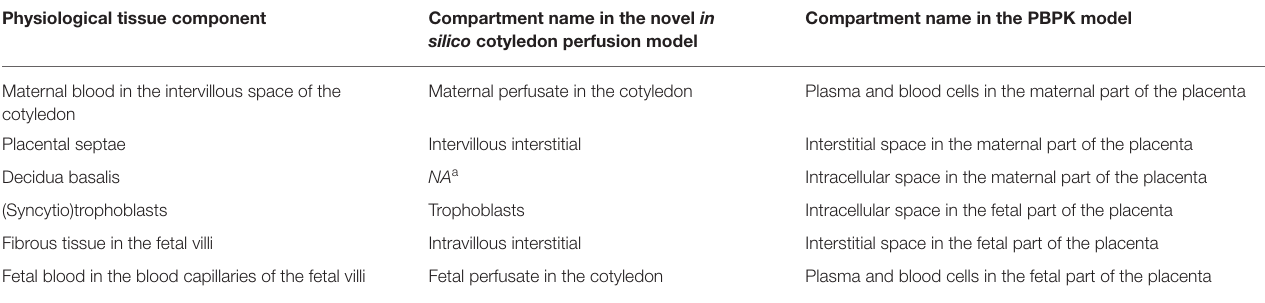
TABLE 1 | Overview of different tissue components and their corresponding compartments in the novel in silico cotyledon perfusion model and the PBPK model. Physiological tissue